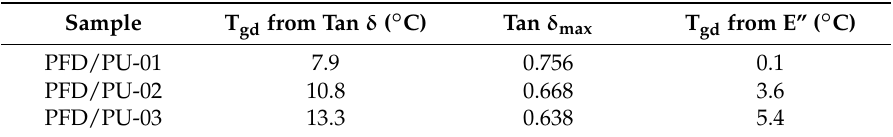
Table 5. DMA results of PFD/PUs.